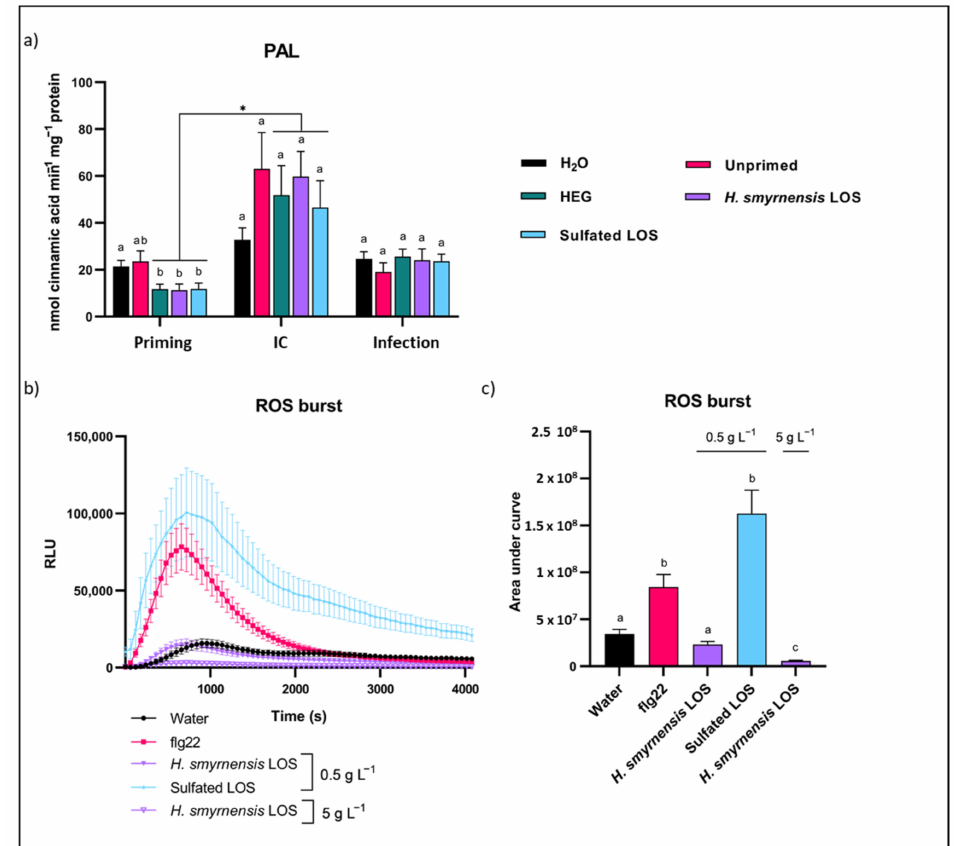
Figure 7. The effect of fructan priming on immunity-related parameters in the rocket- Botrytis cinerea pathosystem. ( a ) Activity of phenylalanine ammonia-lyase (PAL) was measured through production of cinnamic acid on HPLC. Samples were taken after priming or after subsequent infection. Infection control (IC) buffer, without spores, was also used for inoculation. ( b ) The direct effect of fructans as elicitor on the ROS burst was tested, using flg22 as positive control. Unprimed plants were used. Data are expressed as relative light emitting units (RLU). ( c ) Total area under the ROS burst curve was calculated to compare treatments. Bars represent the mean ± SEM. At least 6 ( a ) or 8 ( b , c ) biological replicates were used, and the experiments were repeated 3 times with consistent results. Letters indicate significant differences between treatments ( p < 0.05). Asterisks indicate significant differences between time points for the same priming agent (* p <